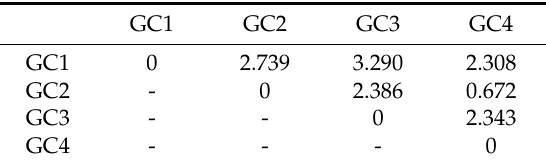
Table 1. Matrix of pilus RMSD values.